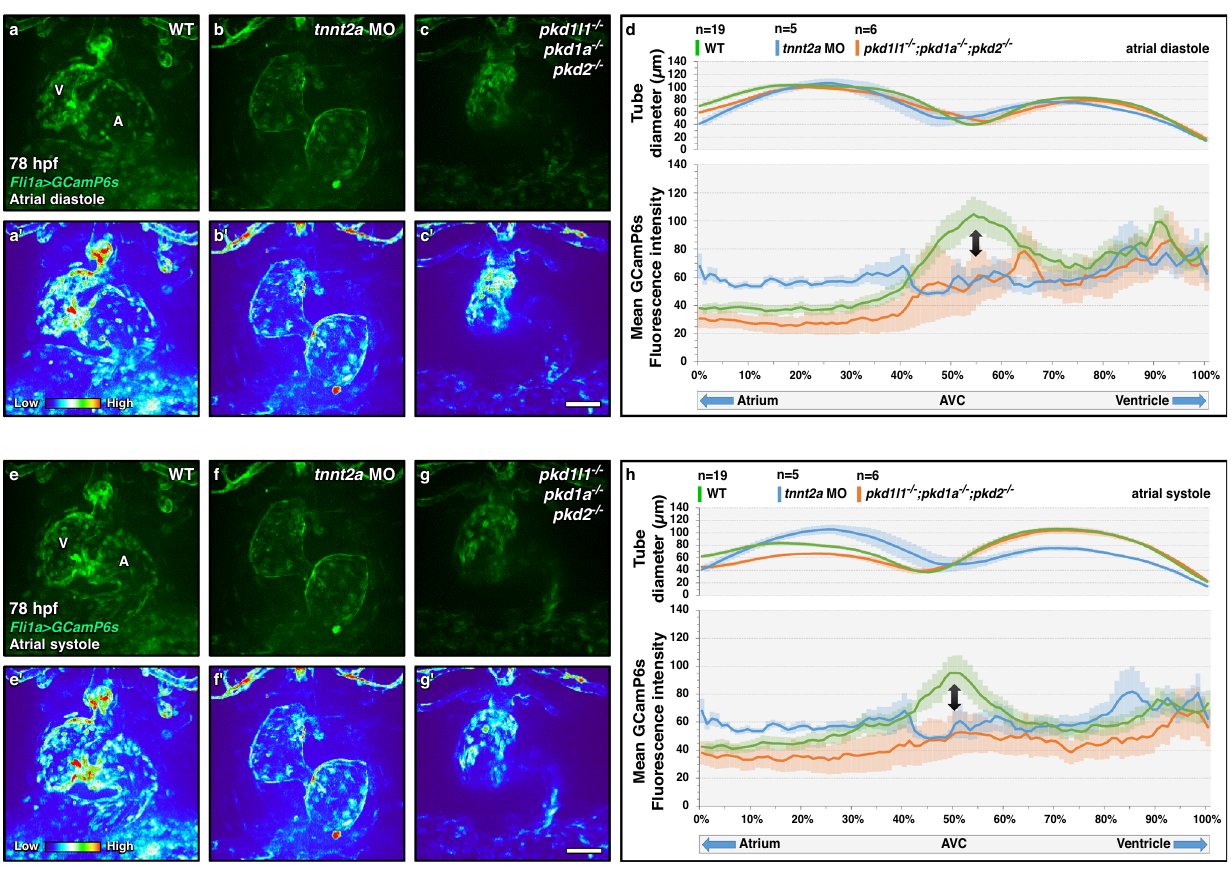
Fig.4|ControlofcalciumlevelsintheatrioventricularcanalbyPkdmembers. a – c , e – g Confocalimagingof78hpf fl i1a:Gal4FF;UAS:GCamP6s wild-type( a , a ′ , e , e ′ ), tnnt2a morphant ( b , b , f , f ′ ) and pkd triple mutant ( c , c ′ , g , g ′ ) hearts during atrial diastole ( a – c ′ ) and systole ( e – g ′ ); maximum projection of 4D-assembled spinning disc movies. d , h Diameter and endocardial calcium levels along the contracting